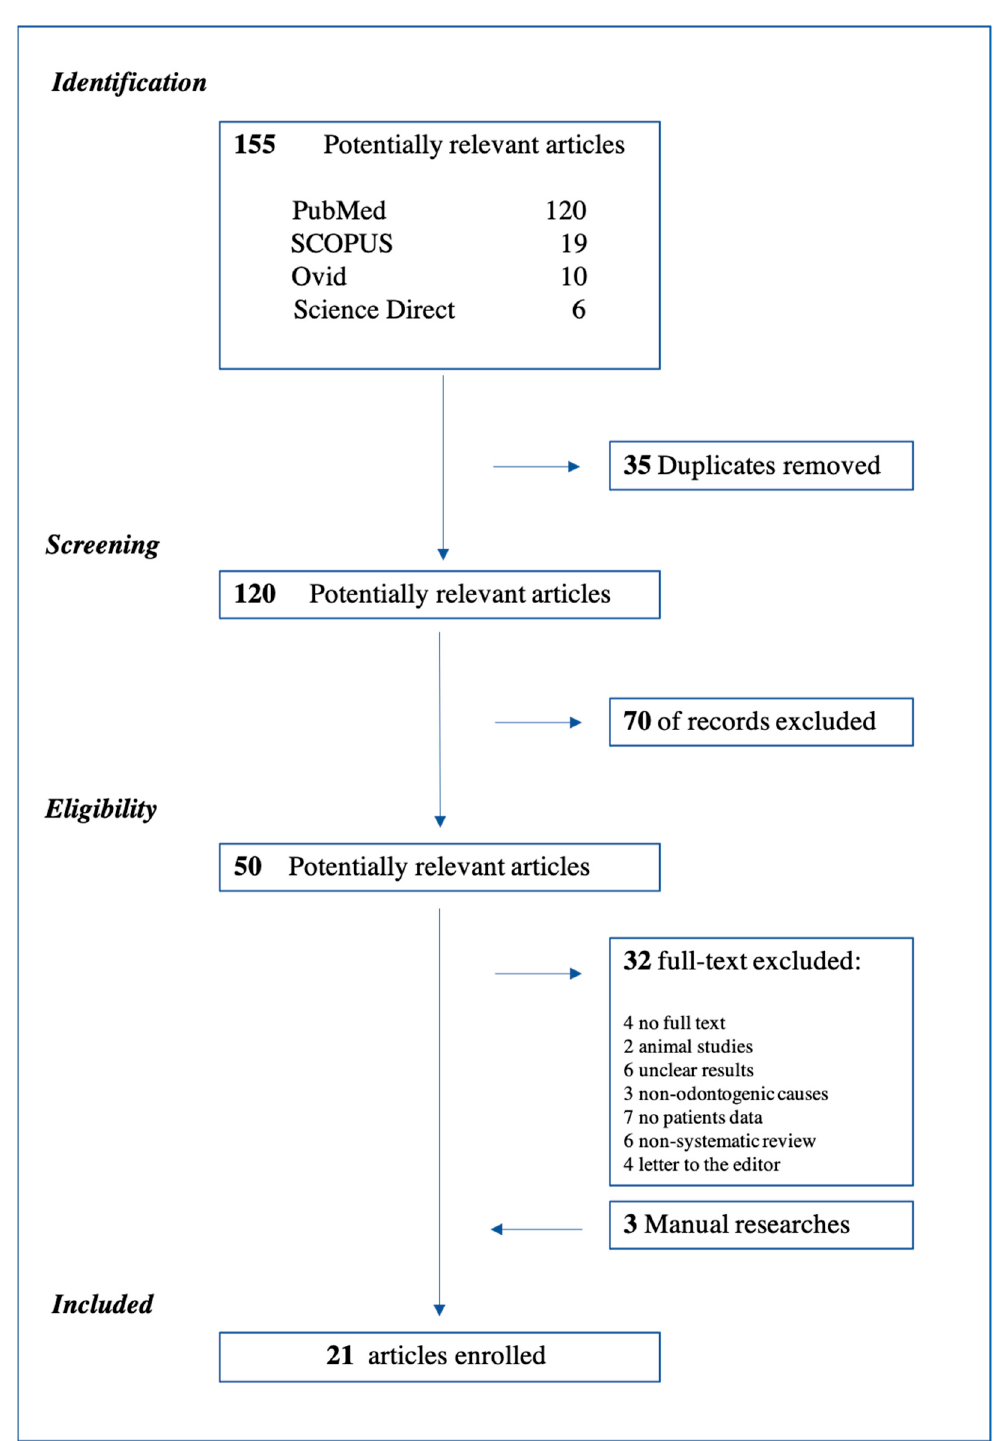
Figure 2. Flow Chart of the study selection. Systematic review was conducted in adherence to PRISMA guidelines.